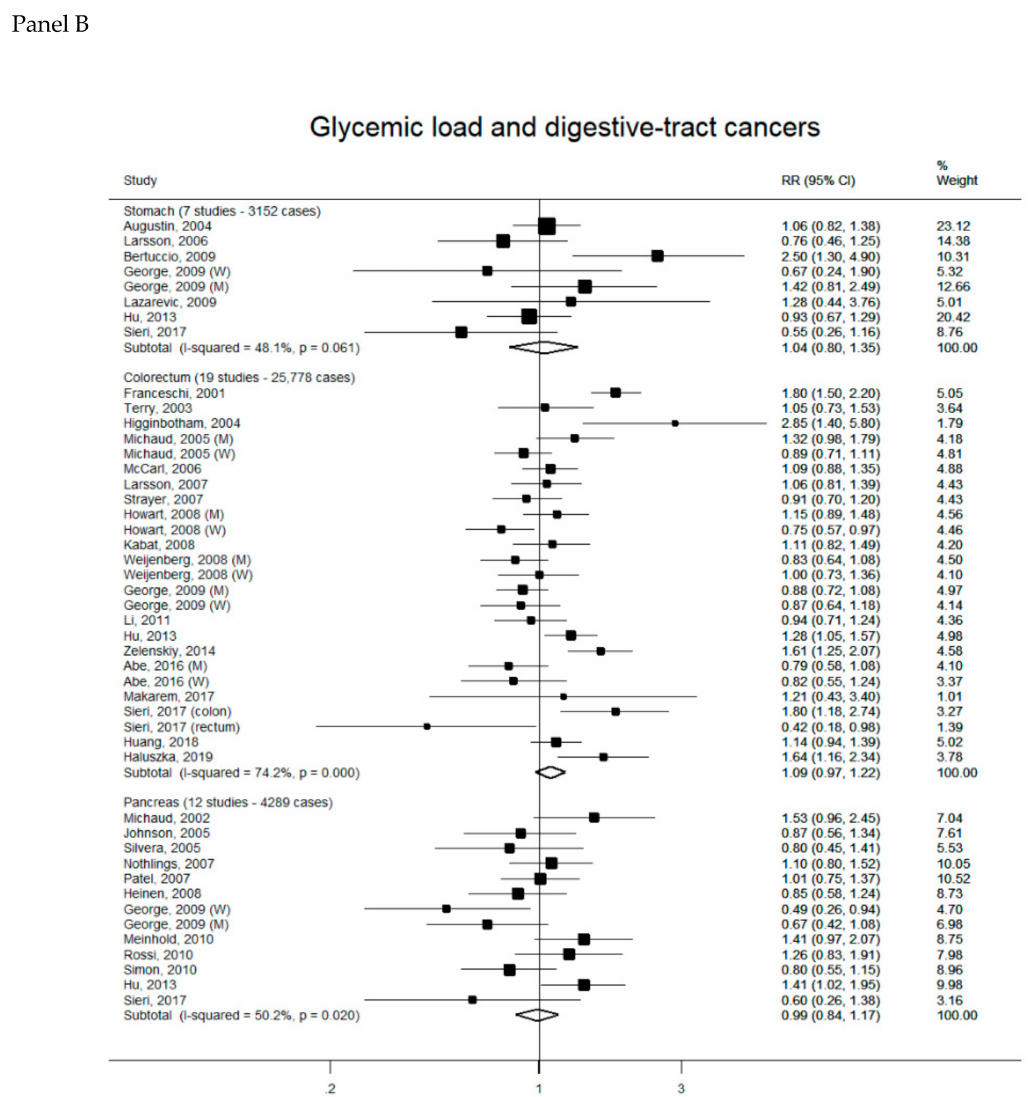
Figure 2. Study-specific and summary relative risks (RRs) of digestive-tract cancers for the highest versus the lowest category of glycemic index (Panel A) or glycemic load intake (Panel